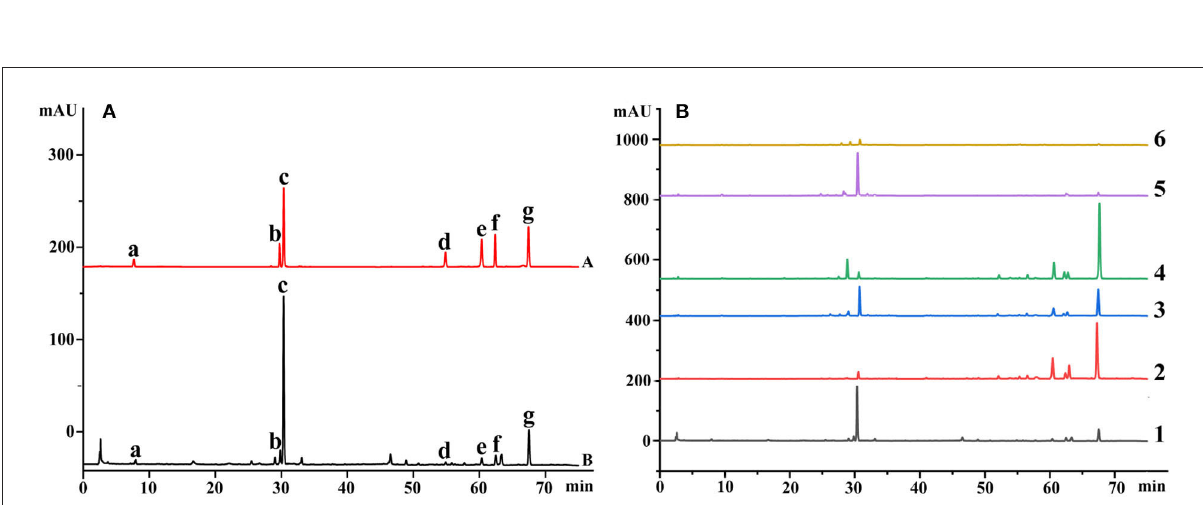
FIGURE3 The representative chromatograms of medicines based on the HPLC-DAD technique (Description: (A) represents the chromatograms of mixed standard solution and Danshen medicines; (B) represents the chromatograms of roots and rhizomes of 6 Salvia species. The chemical compounds are salvianic acid A sodium, rosmarinic acid, salvianolic acid B, dihydrotanshinone I, cryptotanshinone, tanshinone I, and tanshinone IIA according to the retention time, respectively. The roots and rhizomes for Salvia species of 1–6 are S. miltiorrhiza , S. trijuga , S. castanea , S. przewalskii , S. bowleyana , and S. brachyloma ,